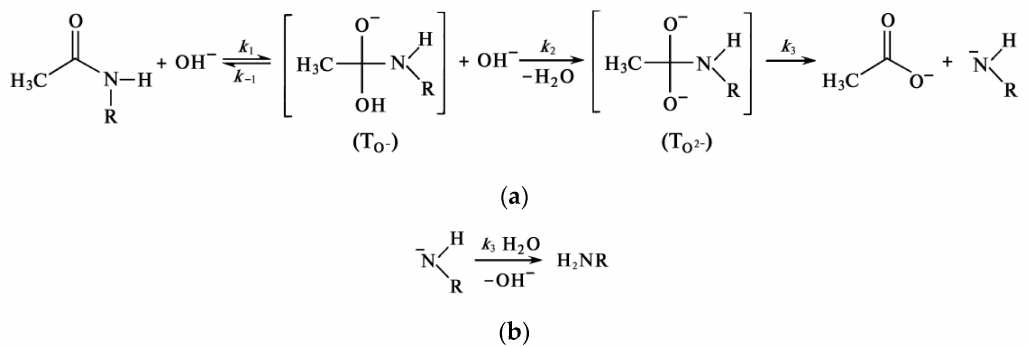
Figure 16. Scheme of ( a ) formation of the amide anion of chitosan NHR- and ( b ) its